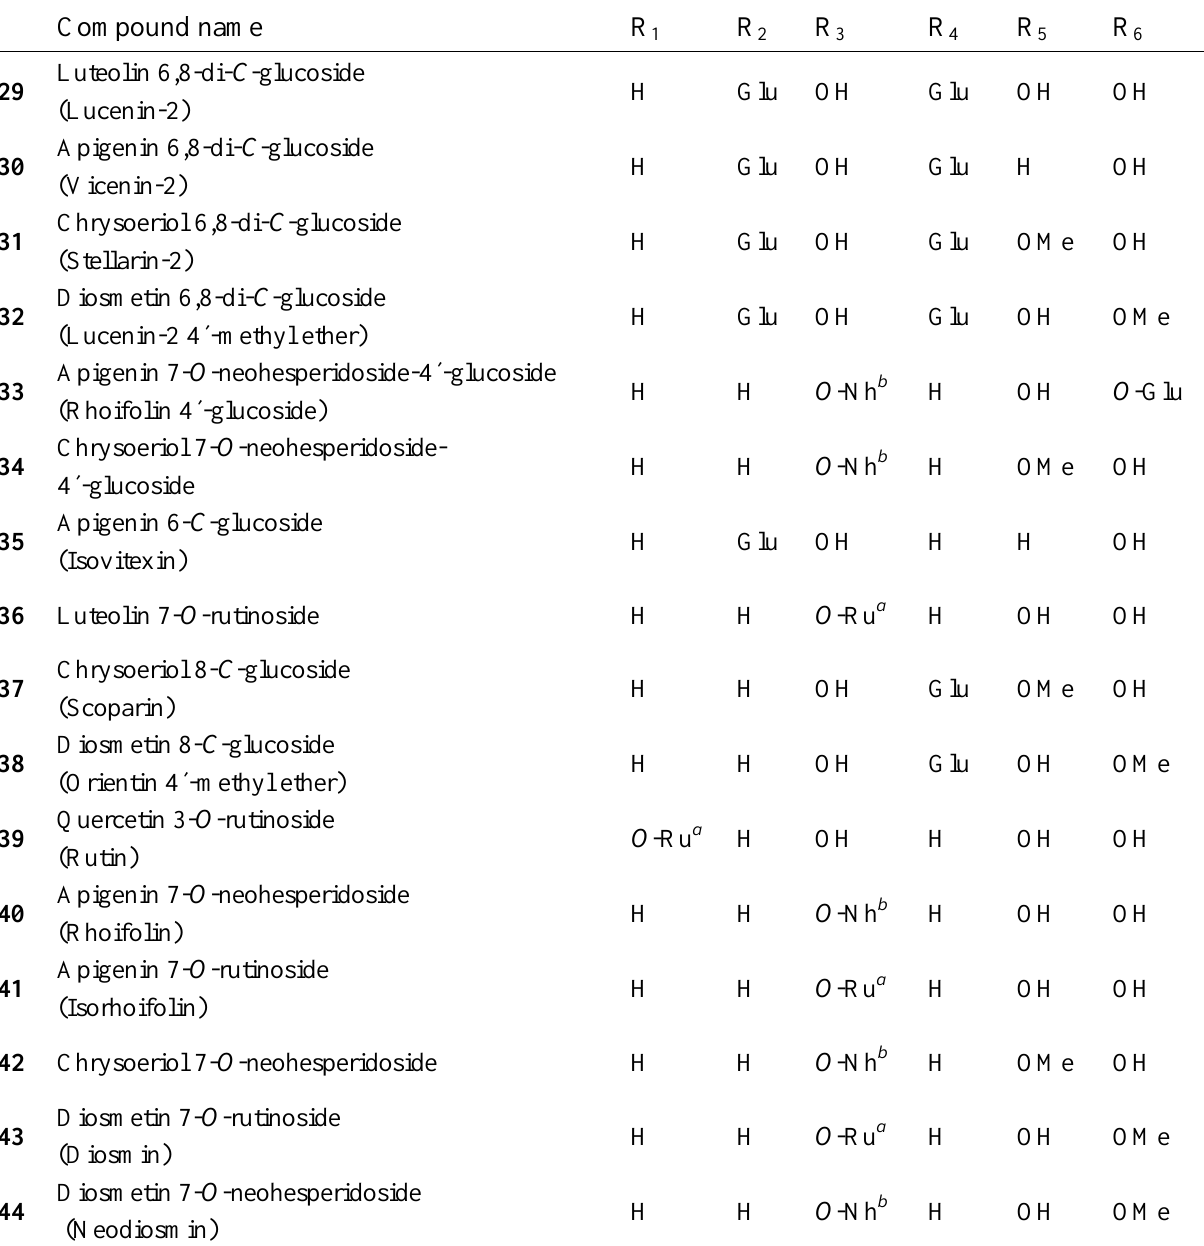
Table 5. Flavone- C -glucosides and flavone- O